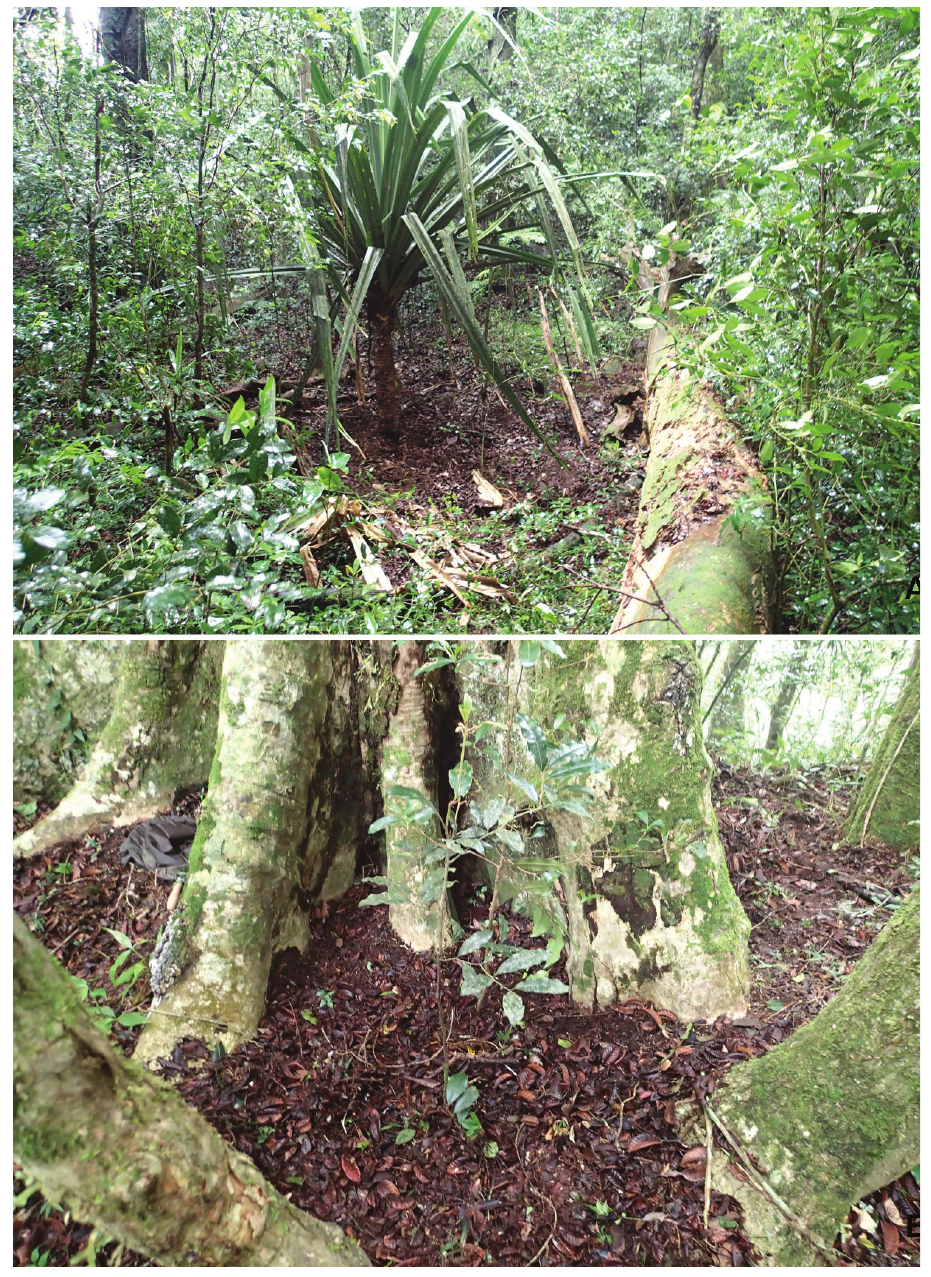
Figure 6. Microhabitats of Cervinotaptera tomhenryi sp. n. in Montagne d’Ambre National Park. A sample MDA/Jan.2015/12 B sample